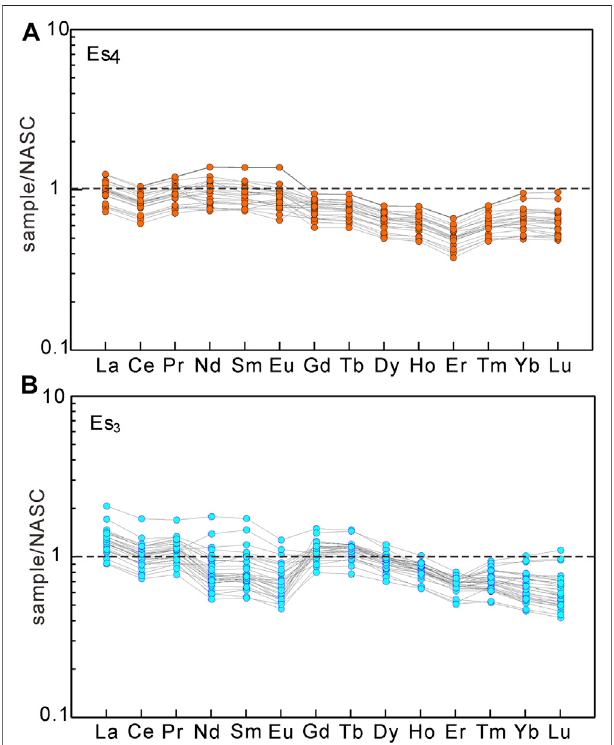
FIGURE 7 | NASC-normalized distribution patterns of rare earth elements (REE) in Es 4 (A) and Es 3 (B) mudstone samples in the Langgu sag, Jizhong subbasin. The NASC refers to the North American shale composite (NASC, Haskin et al., 1968).